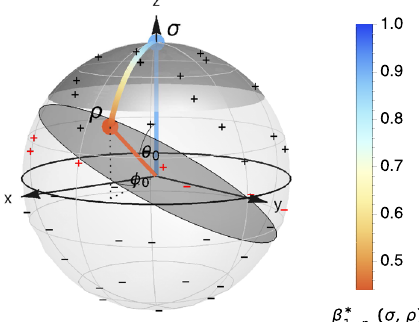
Fig. 3 Example classi fi er for single-qubit quantum states. The decision boundary is represented by the gray disk passing through the origin of the Bloch sphere. The robust region around σ is indicated by the dark spherical cap. States belonging to different classes are marked with + and – and are color red if not classi fi ed correctly. The colorbar indicates different values for the optimal type-II error probability β (cid:4) ð σ ; ρ Þ . We see that, for the given classi fi er, the state ρ is not 1 (cid:2) p A contained in the robust region around σ since the optimal type-II error probability is less than 1/2 as indicated by the colorbar. The state ρ is thus not guaranteed to be classi fi ed correctly by every classi fi er with the same class probabilities. In the asymmetric hypothesis testing